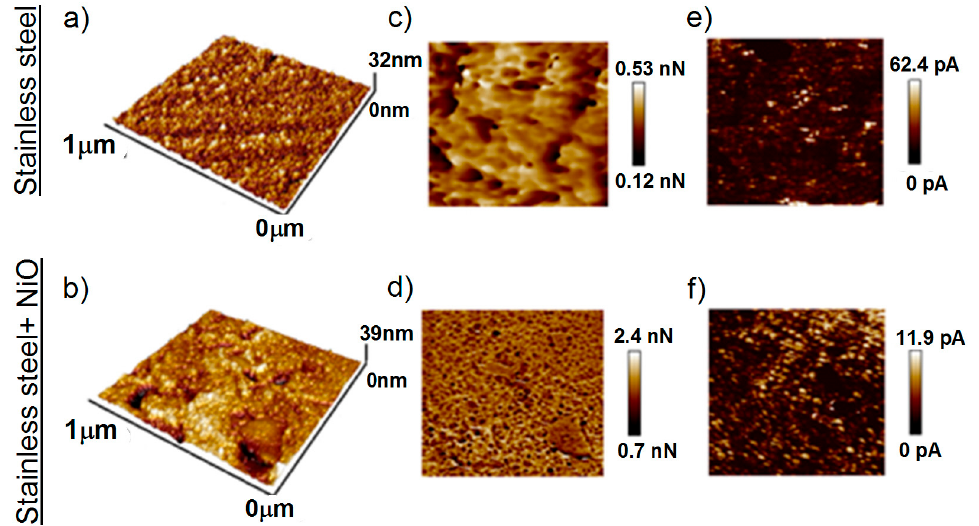
Figure 6. AFM 3D surface topographies adhesion maps ( a , b ); conductivity maps ( c , d ); and surface electrical conductivity ( e , f ) of stainless-steel substrate and NiO x nanofilm deposited on a stainless-steel substrate.